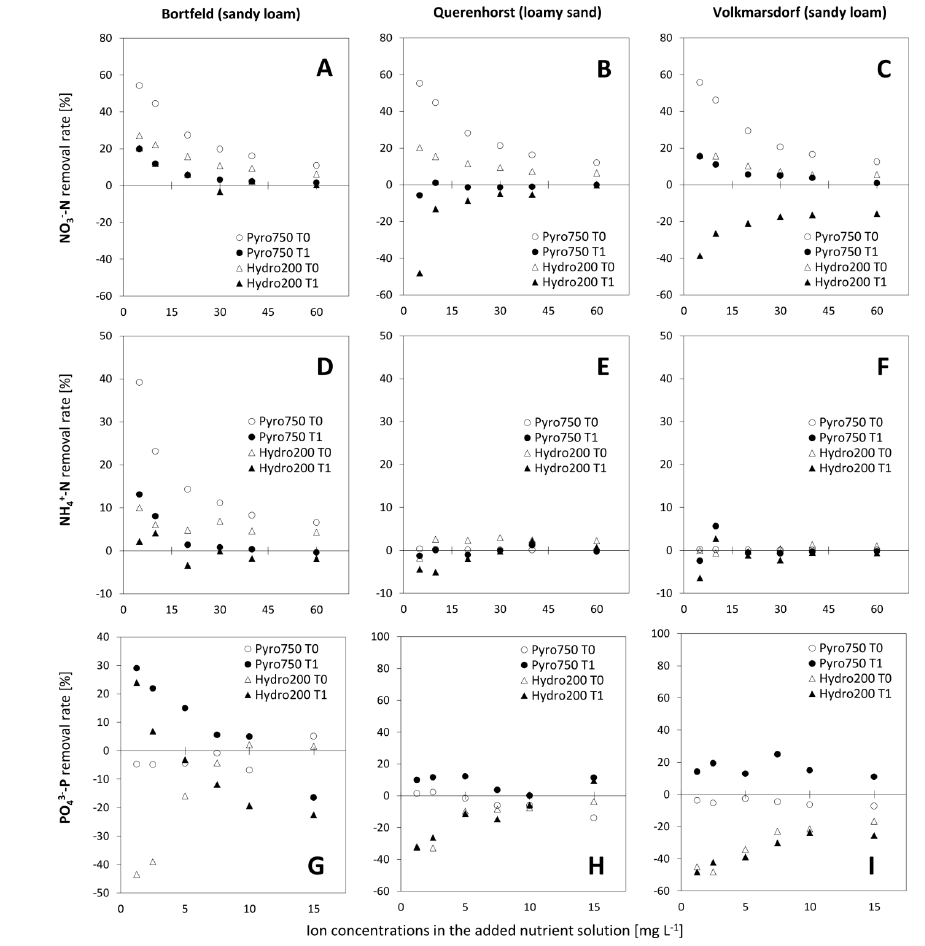
− -N (a–c) , NH + -N (d–f) , and PO 3 − -P (g–i) removal rate relative to the control for fresh ( T 0 ) and degraded ( T 1 ) Figure 4. Mean NO 3 4 4 pyrochars of the field experiment (for all treatments, n = 3). Test statistics can be found in Tables S5, S7, and